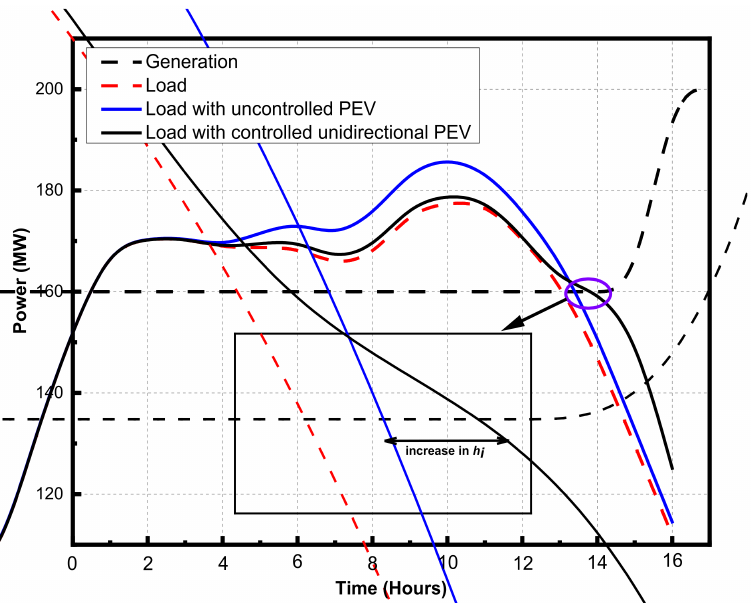
Figure 8. Load consumption for one scenario during an interruption period with 20% BEV penetration and 7.2 kW charger